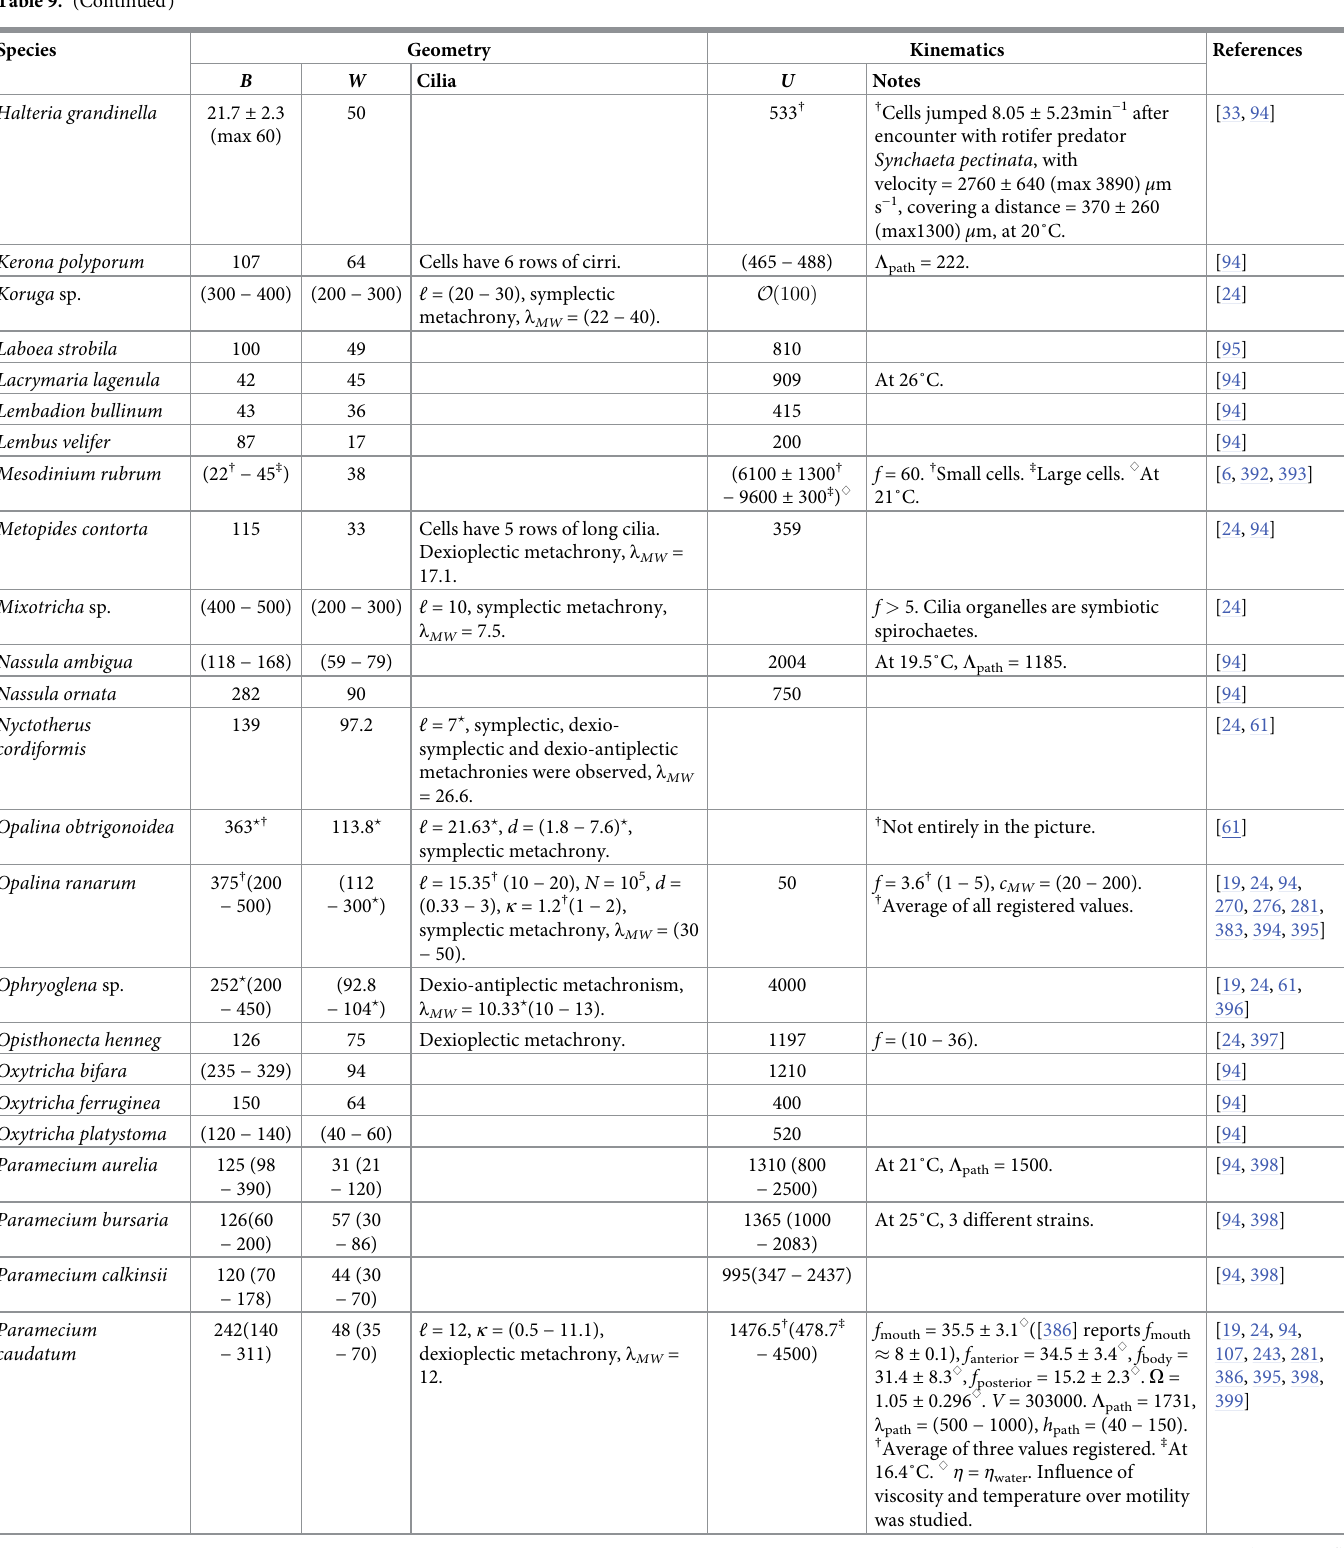
16.4˚C. ♢ η = η water . Influence of viscosity and temperature over motility was